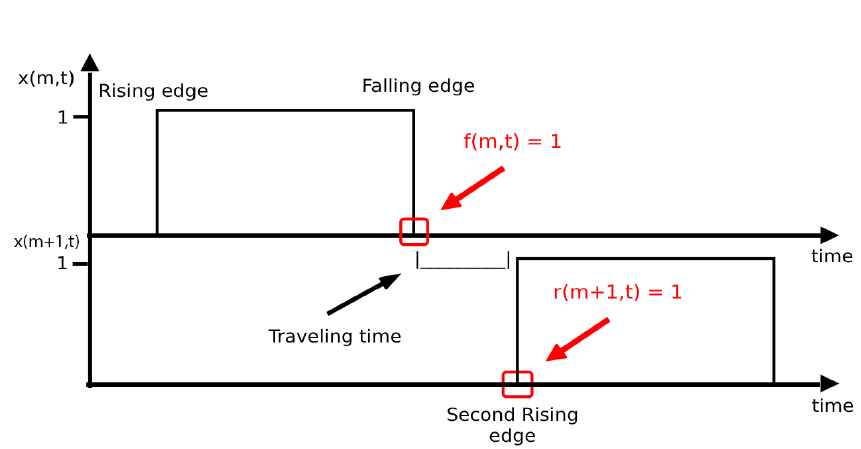
Figure 2. Capturing rising and falling edges of x m , t .